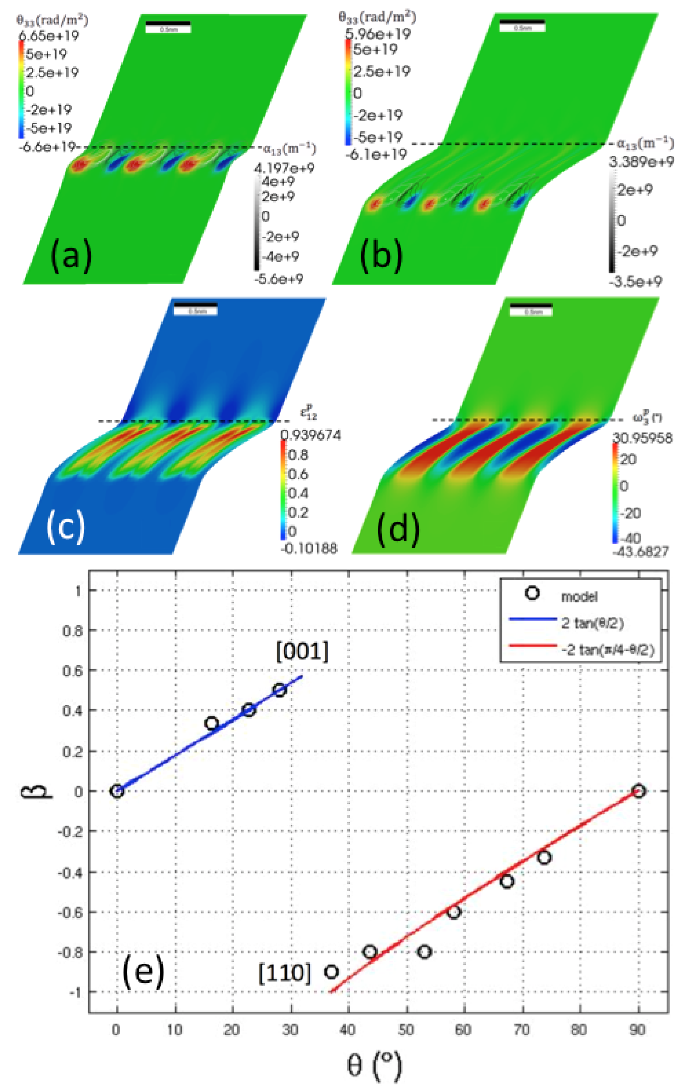
Figure 4. Disclination model for shear-coupled boundary migration. ( a , b ): Wedge-disclination density θ 33 (rad/m 2 ) (color coded) and edge dislocation density α 13 (m − 1 ) (black/white contours), during migration of a ∑ 5(310) symmetric < 001 > tilt grain boundary of misorientation 36.87 ◦ . Two snapshots are shown at 1 ms ( a ) and 10 ms ( b ); ( c , d ): Plastic shear strain (cid:101) p ω p ( ◦ ) ( d ) generated during the migration. In ( a – d ), the black dashed-line shows the initial position 3 of the grain boundary. ( e ): Shear-coupling factor as a function of grain boundary misorientation. The circles show values obtained with the disclination model while the solid lines show the <001> and <110> shear deformation modes proposed in